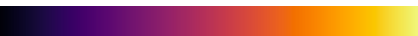
Figure 4. Inferno color